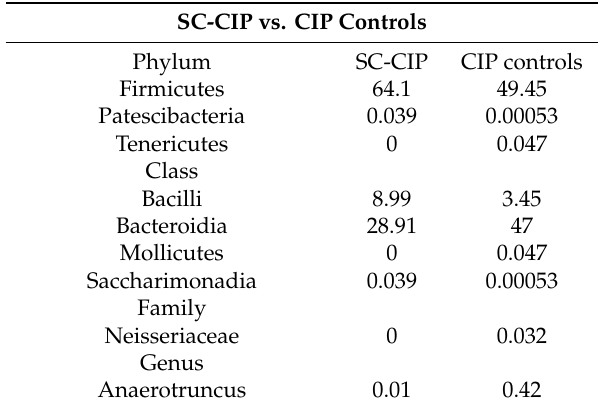
Table 8. Taxonomic di ff erences found with analysis of composition of microbiomes between the SC-CIP group and CIP controls on all taxonomic